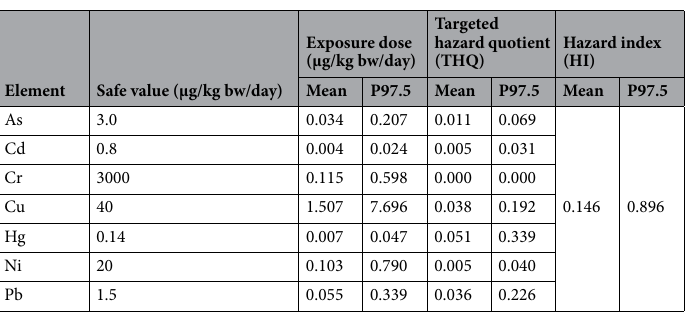
Hazard index (HI)